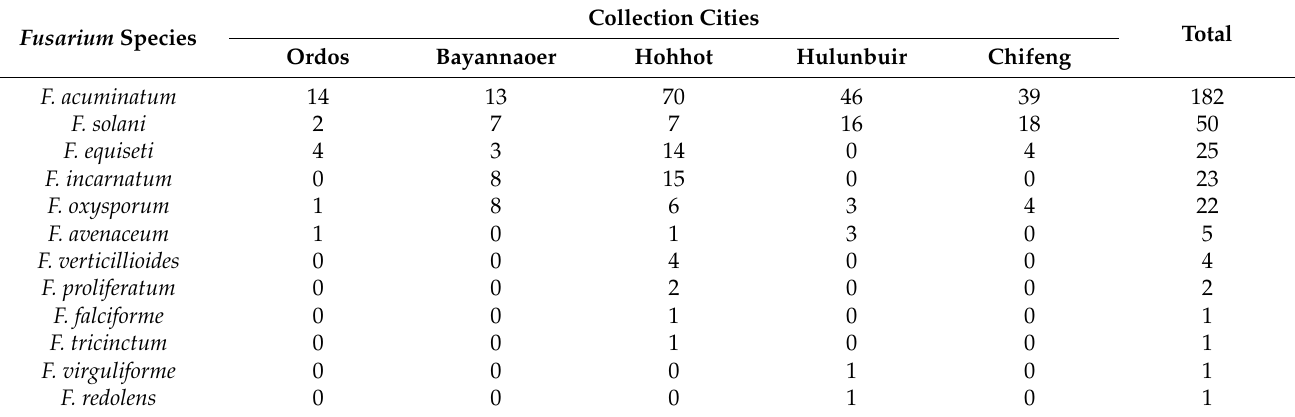
Table 3. Isolation of Fusarium spp. strains of alfalfa root rot from different regions of Inner Mongolia,